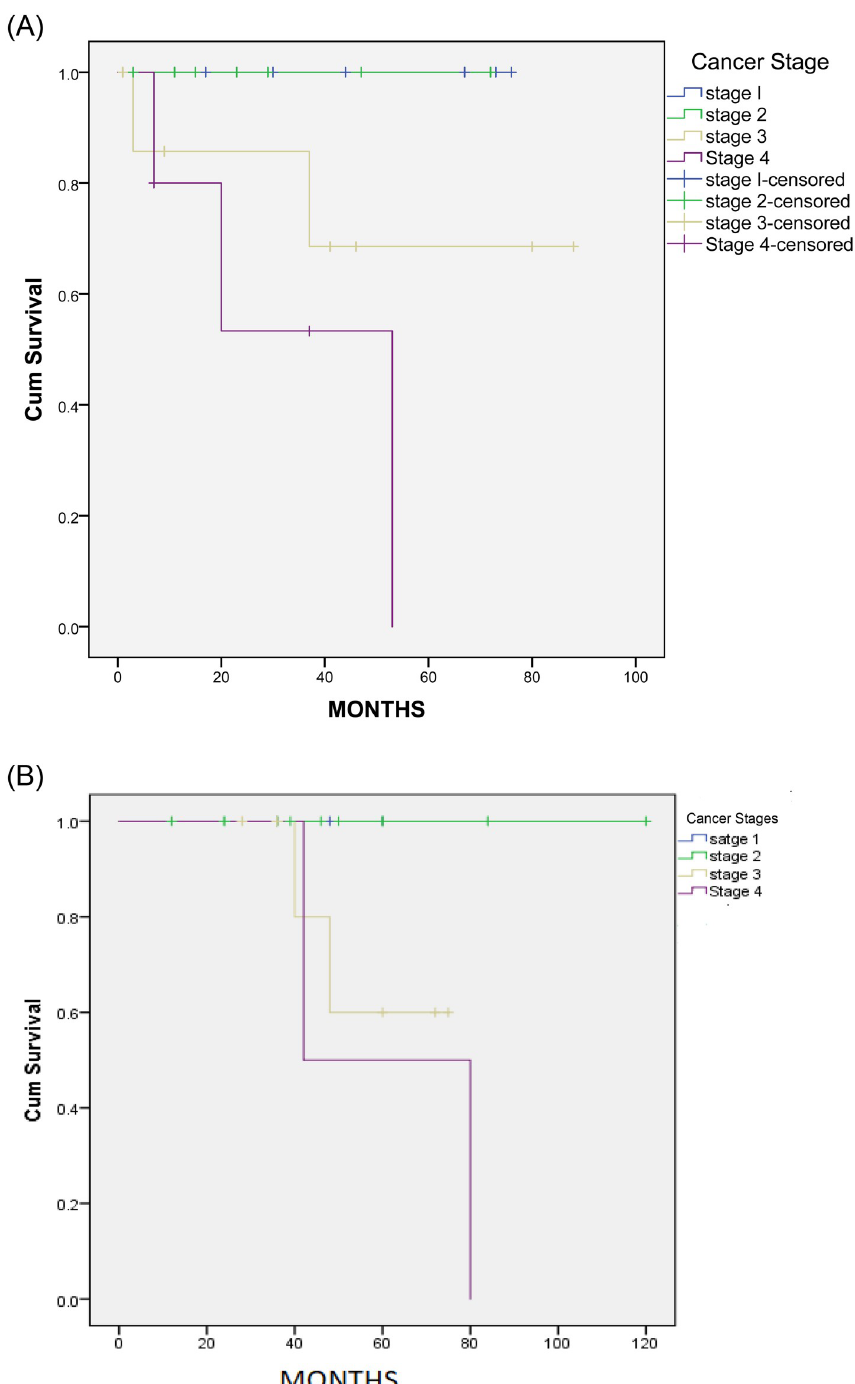
Fig 4. Kaplan-Meier survival curve among asthmatic and control patients. (A) Kaplan-Meier survival curve showing the speed of the occurrence of death amongst asthma patients who had cancer at different stages. There was no significance in death progression among patients who in stage 1,2, and 3 (P = 0 . 2) but there were significant between stage 1,2 and 4 ( P = 0 . 01) . (B) Kaplan-Meier survival curve showing the speed of the occurrence of death amongst control patients with cancer at different